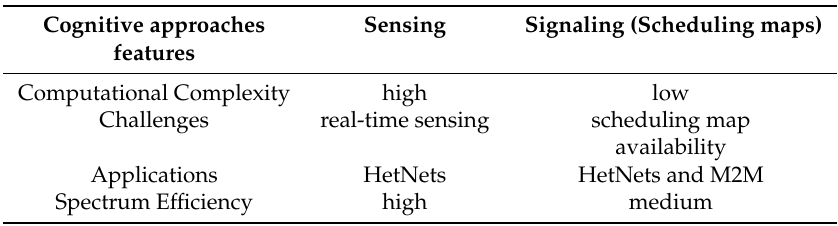
Table 2. Short-term cognitive approaches